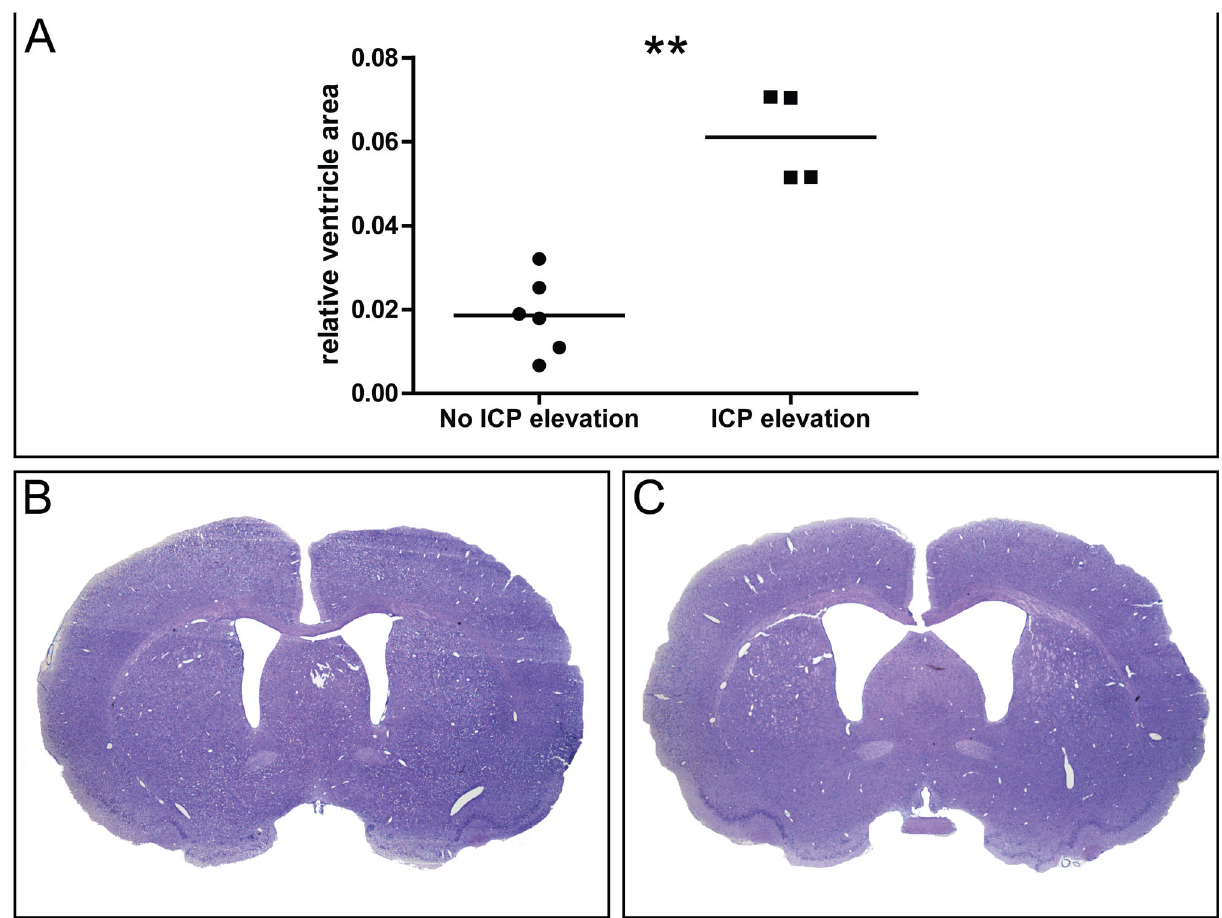
Figure 4. Intracranial pressure and histology. Relative ventricle area (ventricle area / brain area) (A) in SAH animals with normal ICP (≤ 10 mmHg) or elevated ICP (> 10 mmHg). Representative micrographs of coronal Nissl stained brain sections in a SAH animal with normal ICP (B) and a SAH animal with ICP elevation (C). Mean is shown. ** p<0.01.